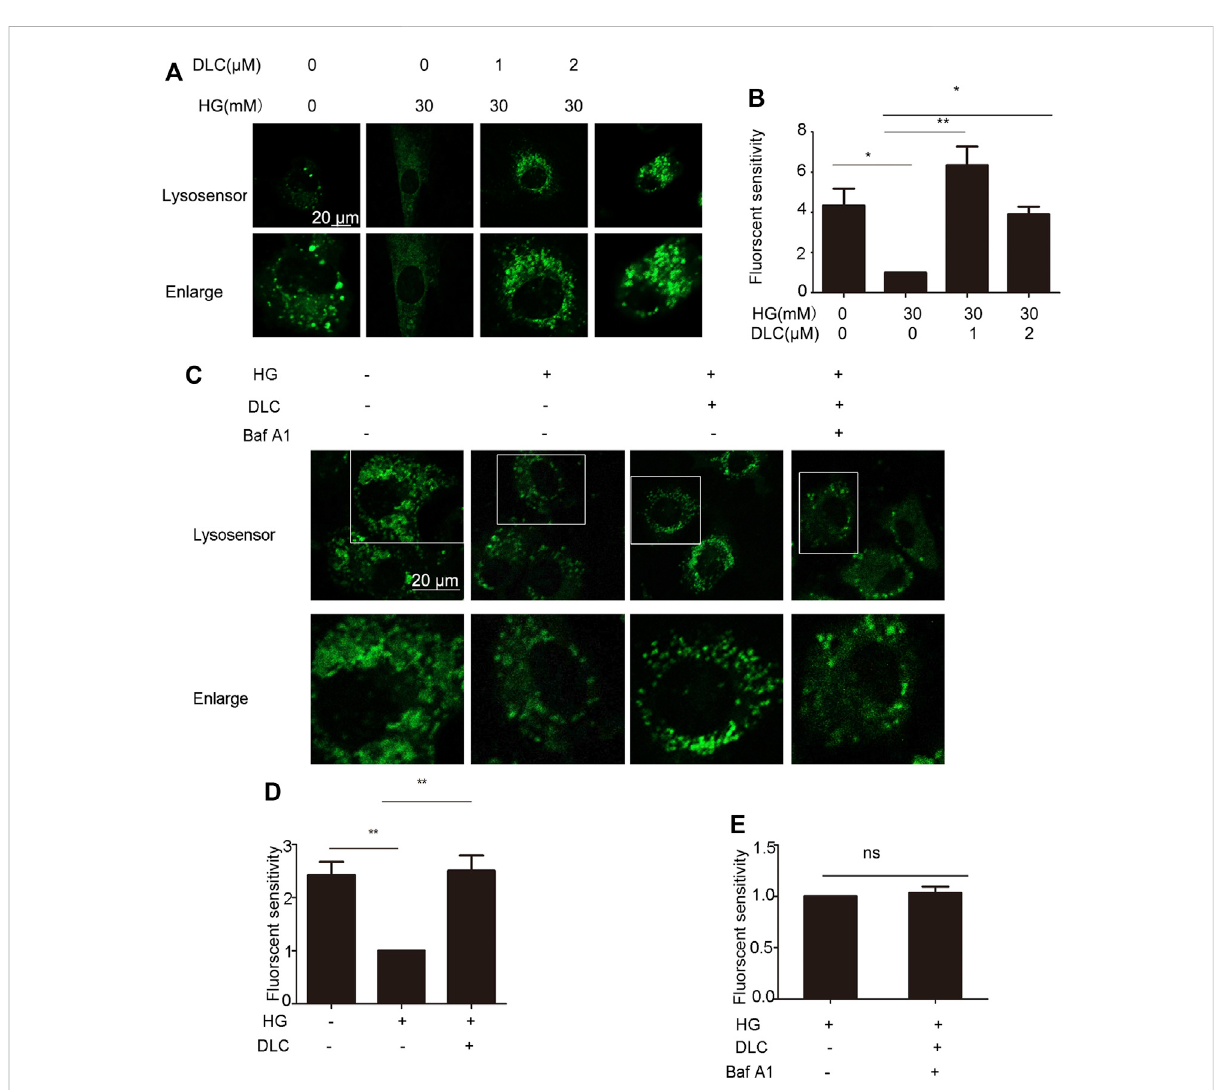
FIGURE 7 DLCprotectedtheprotonchanneloftheV-ATPase. (A,B) :HUVECsweretreatedwithDLC(0,1,2 μ M)underHGconditionsfor24 h,H + levelsin lysosomes were detected by Lysosensor ™ Green DND-189. (C – E) : HUVECs were treated with DLC (1 μ M) and Baf A1 (5 μ M) for 24 h under HG condition, H + levels in lysosomes were detected by Lysosensor ™ Green DND-189. Scale bar: 20 μ m, * p < 0.05, ** p < 0.01, n =